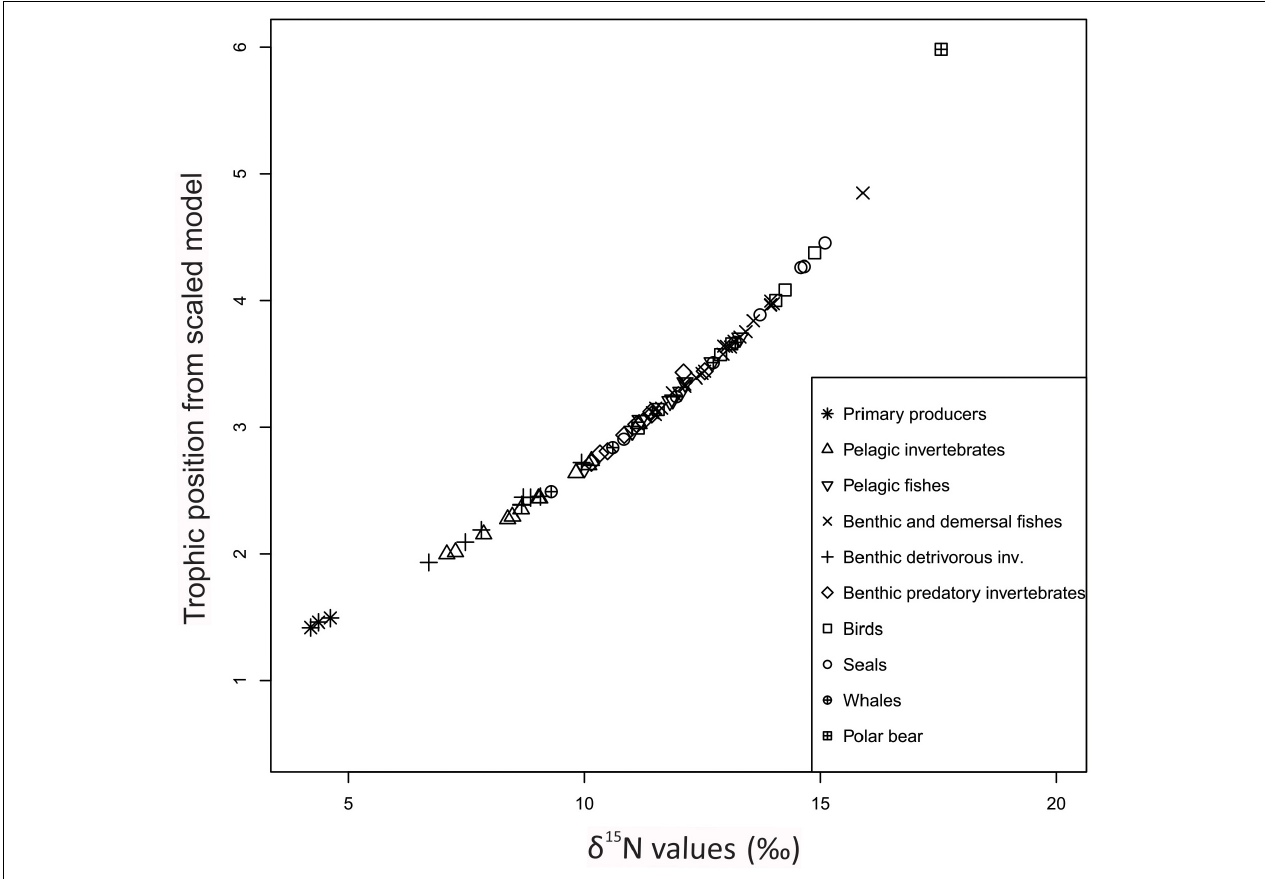
FIGURE 6 | Relationship between trophic position from scaled model (TP sca ) and δ 15 N values for various functional groups